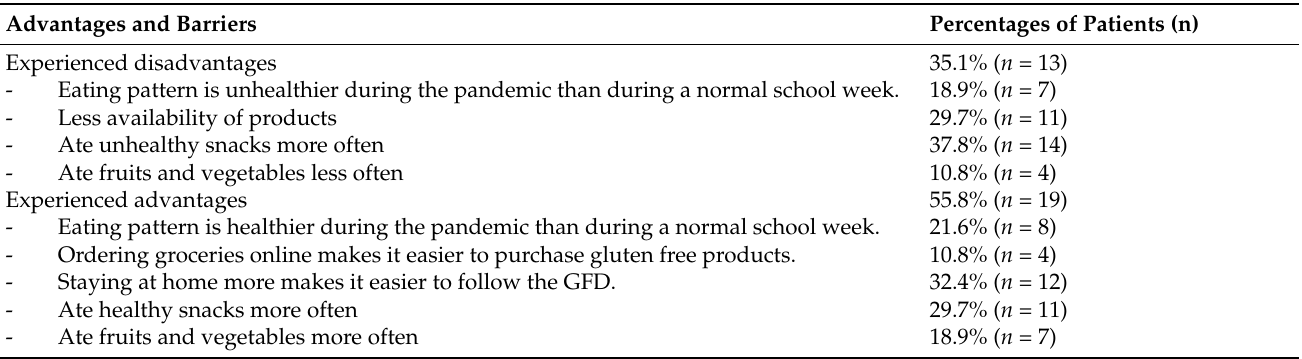
Table 3. Experiences regarding eating patterns/perceived advantages and barriers regarding the gluten free diet (GFD) during the COVID-19